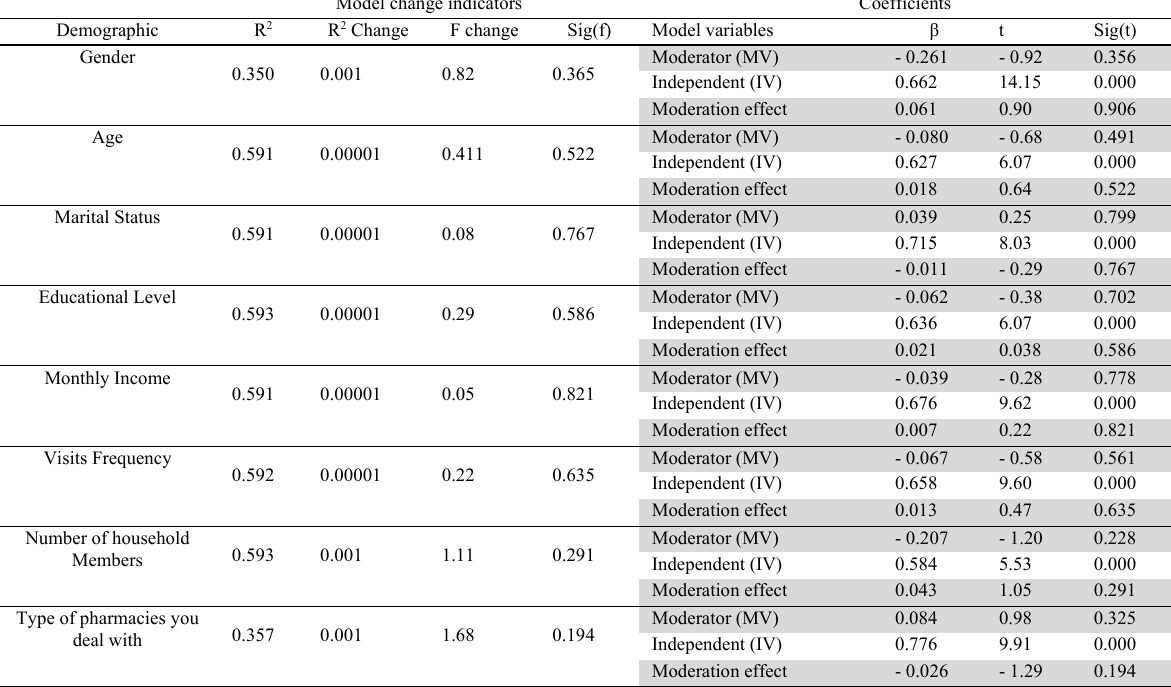
The moderation effect of demographic variables on the relationship between independent and dependent